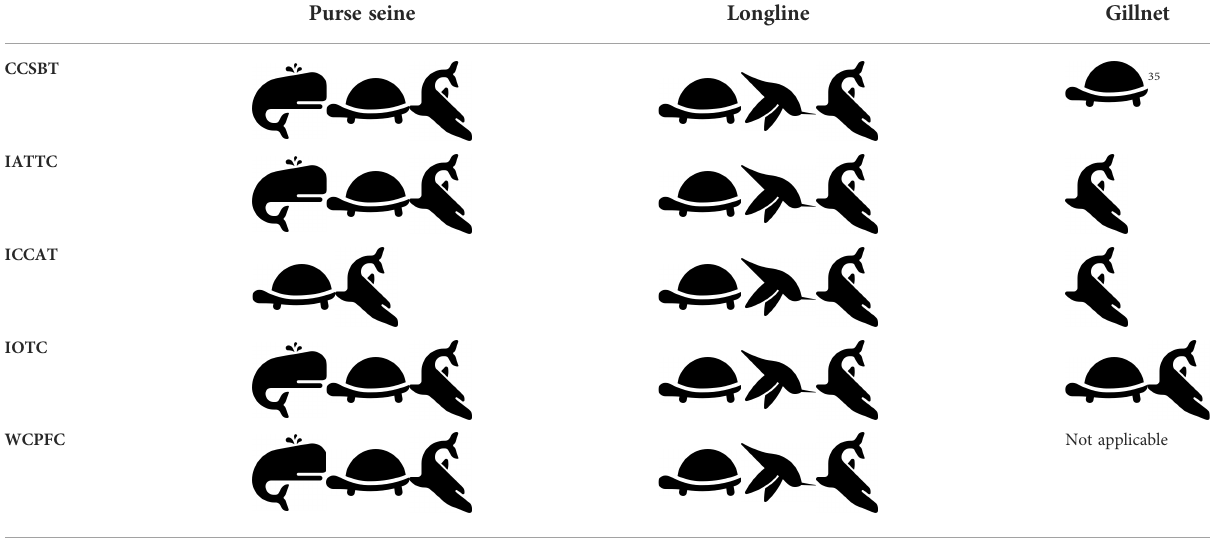
TABLE 4 Binding CMMs focused on addressing other taxa (whales, sea birds, sea turtles, and sharks) with fi shing interaction measures in tRFMOs 34 . Purse